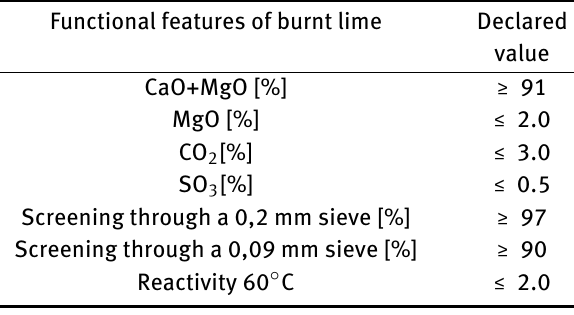
Table 2: Quantitative composition of lime-silicate